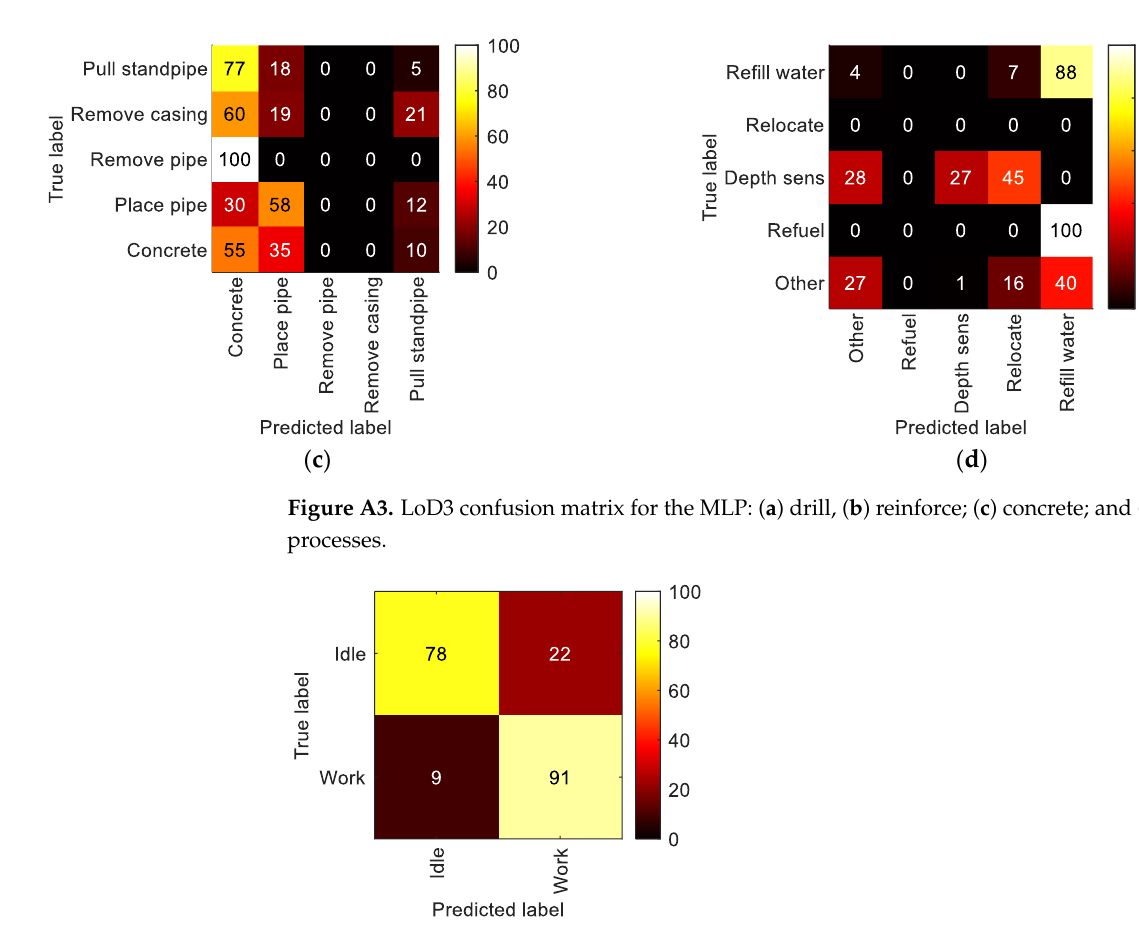
Figure A4. LoD1 confusion matrix for the DeepConvLSTM.